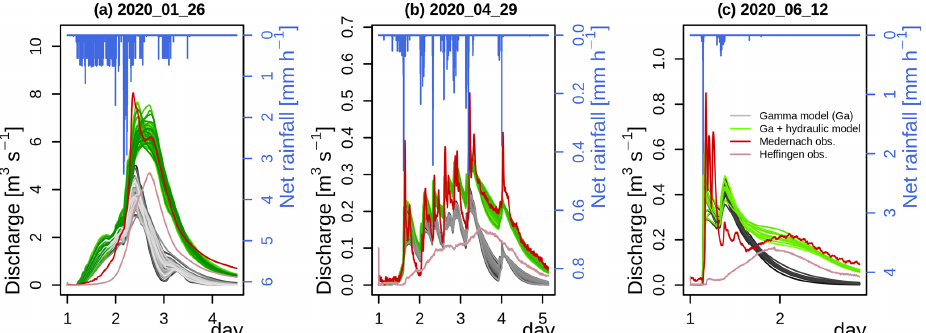
Figure 8. Examples of simulated events on the Heffingen–Medernach catchment section. The gray lines correspond to the HM runoff transfer only, while the green lines correspond to this runoff transfer + the hydraulic transfer of the Heffingen inflow.